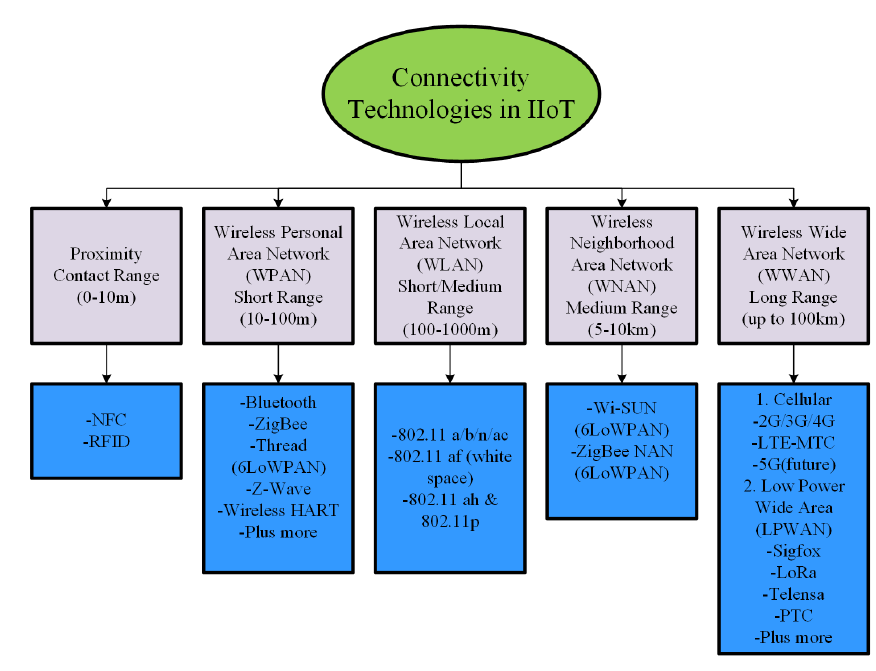
Figure 6. Different connectivity technologies in